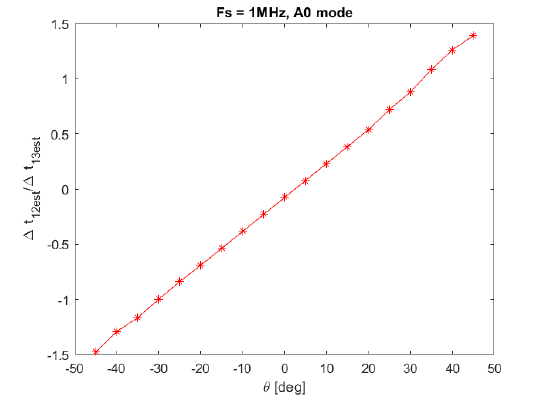
Figure 6. Estimated ratio of differences in time of arrival (DToAs) ( ∆ t 12 est / ∆ t 13 est ) with respect to the actual DoA ( θ ) for the case of A 0 mode